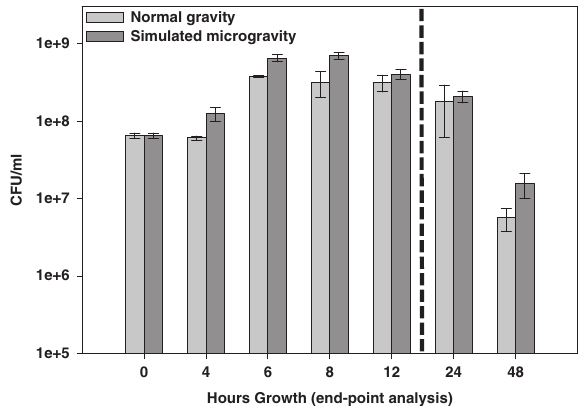
Fig. 1 End-point growth curve analysis of S. mutans simulated microgravity and normal gravity HARV cultures. Simulated micro- gravity ( dark gray bars ) and normal gravity ( light gray bars ) HARV end-point growth was measured by serial dilution and CFU/ml plating at t = 0 (time of inoculation; average of n = 4 independent experiments), and t = 4, 6, 8, 12, 24, and 48 h postinoculation (average of n = 2 independent experiments per time point per growth condition), as described in “ Materials and methods ” . The vertical dotted line on the graph indicates that the t = 24 and 48 h data were obtained in a separate experimental run from the t = 4, 6, 8, and 12 h time points. Error bars = standard error of the mean (SEM)